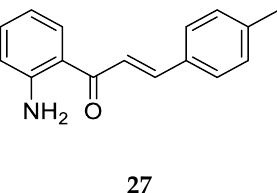
Figure 22. Chemical structure of 2-aminochalcone derivatives with methylation on ring B.